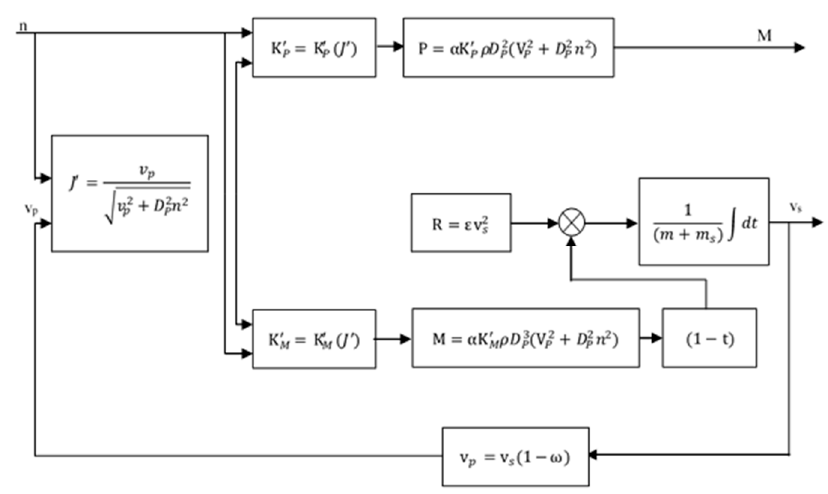
Figure 6. Diagram of the ship-propeller math model.